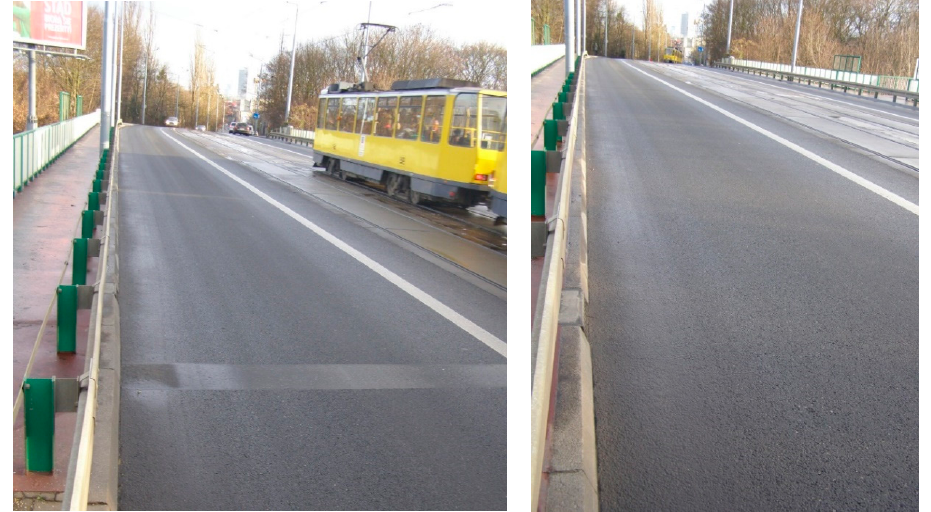
Figure 8. Current condition of pavement with the protective layer made of stone mastic asphalt (SMA) 5 mixture with increased content of bitumen mastic on the overpass supporting Mickiewicza St. in Szczecin (year of completion: